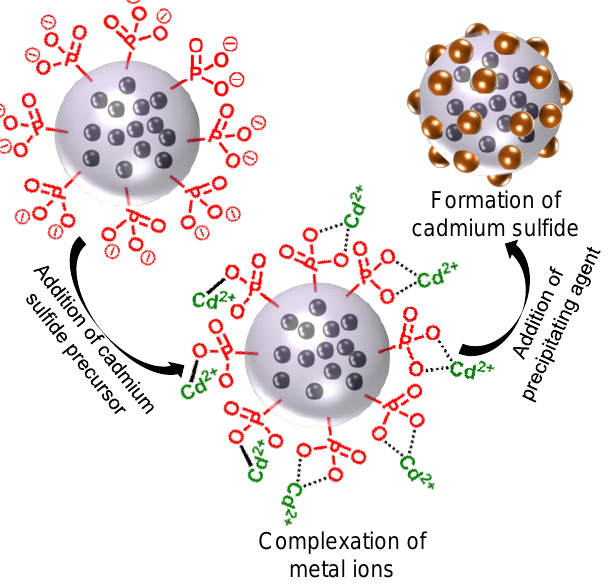
Figure 9. Mechanism of metal chalcogenide formation at the surface of phosphonate functionalized latex particles with magnetic iron oxide core. Reprinted with permission from [108]. Copyright 2013, American Chemical